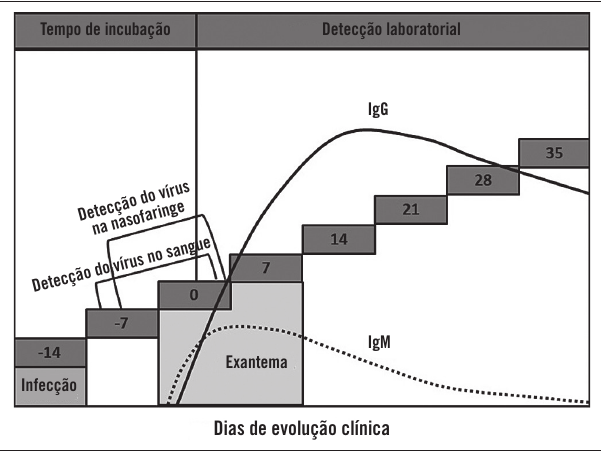
Figura 1 − Evolução clínica e laboratorial do sarampo IgM e IgG: imunoglobulinas das classes M e